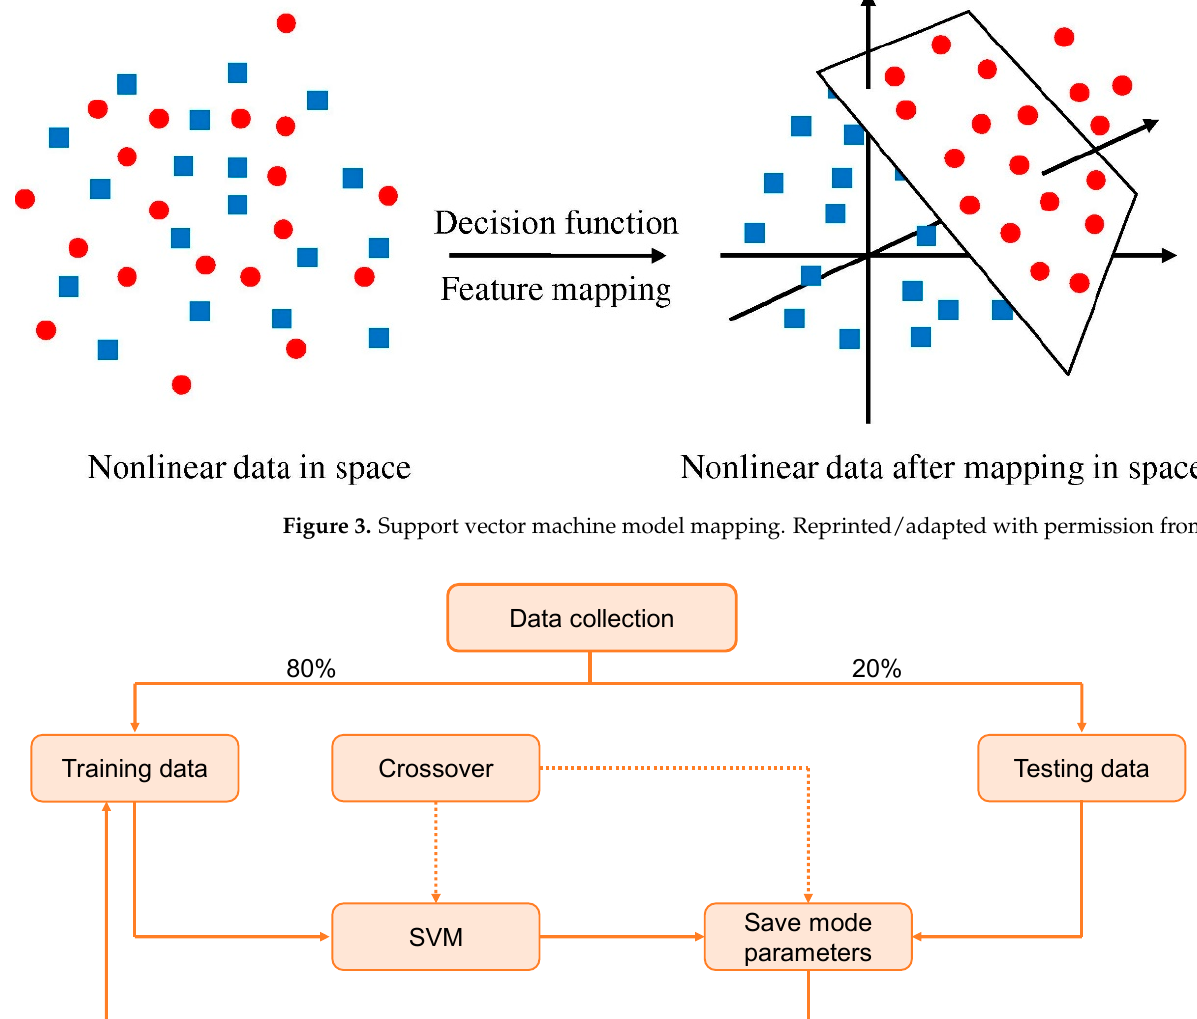
Figure 2. Sequence employed for the study.